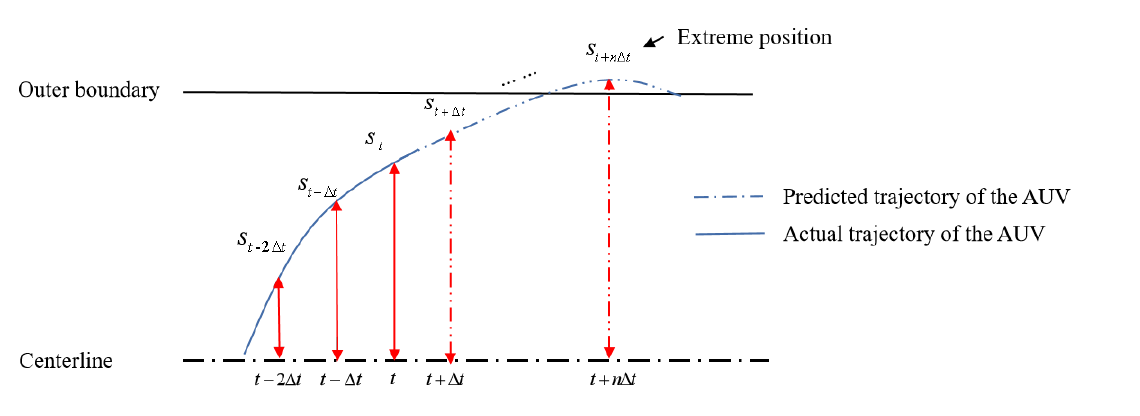
Figure 1. Schematic diagram of the PRTC scheme.